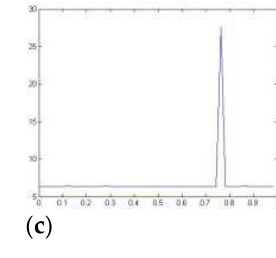
Figure 8. ( a ) PSNR for ×10, ( b ) PSNR for ×20, ( c ) PSNR for ×30.